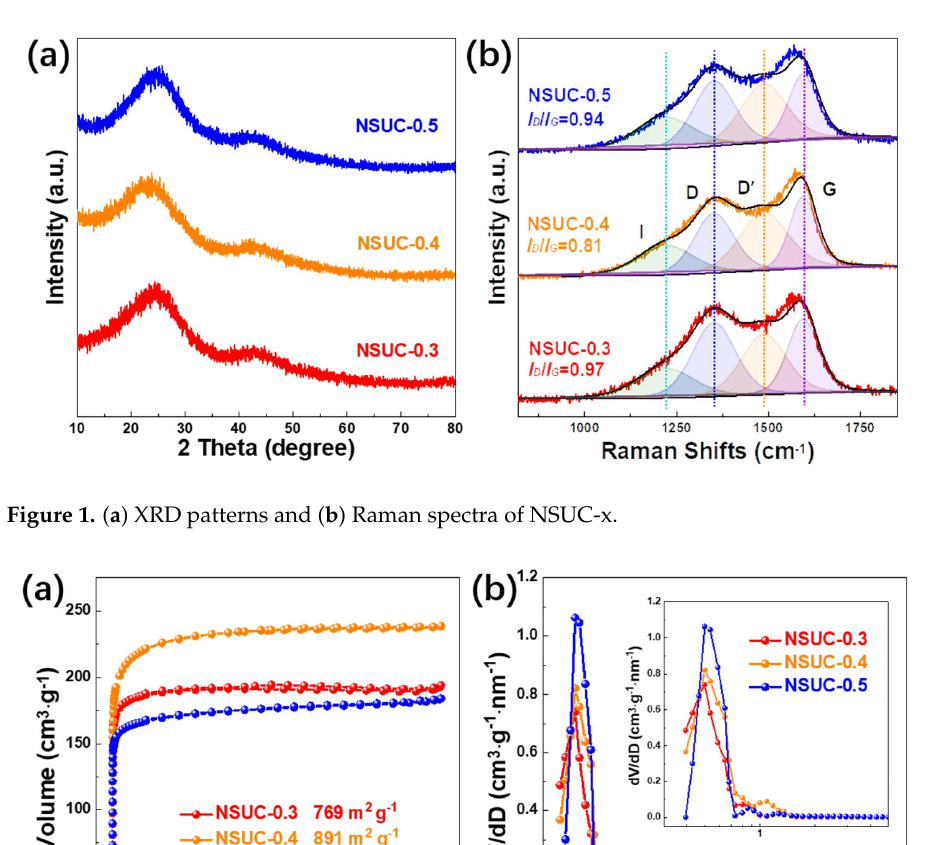
Figure 1. ( a ) XRD patterns and ( b ) Raman spectra of NSUC ‐ x.